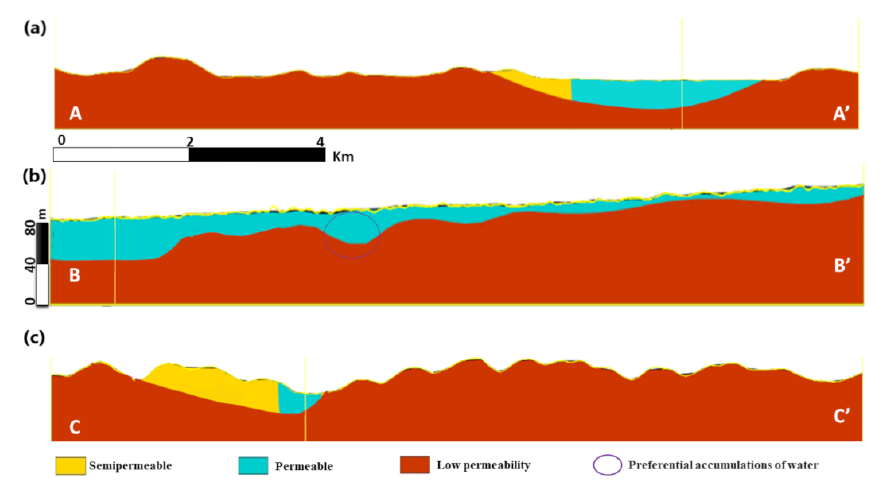
Figure 9. ( a ) A–A’ cross-section of the lower part, in the broadest area of the alluvial. ( b ) B–B’ cross-section along the permeable zone shows the water accumulations’ geometry, highlighting the preferential accumulations. ( c ) C–C’ cross-section of the geometry of the preferential accumulations of water.